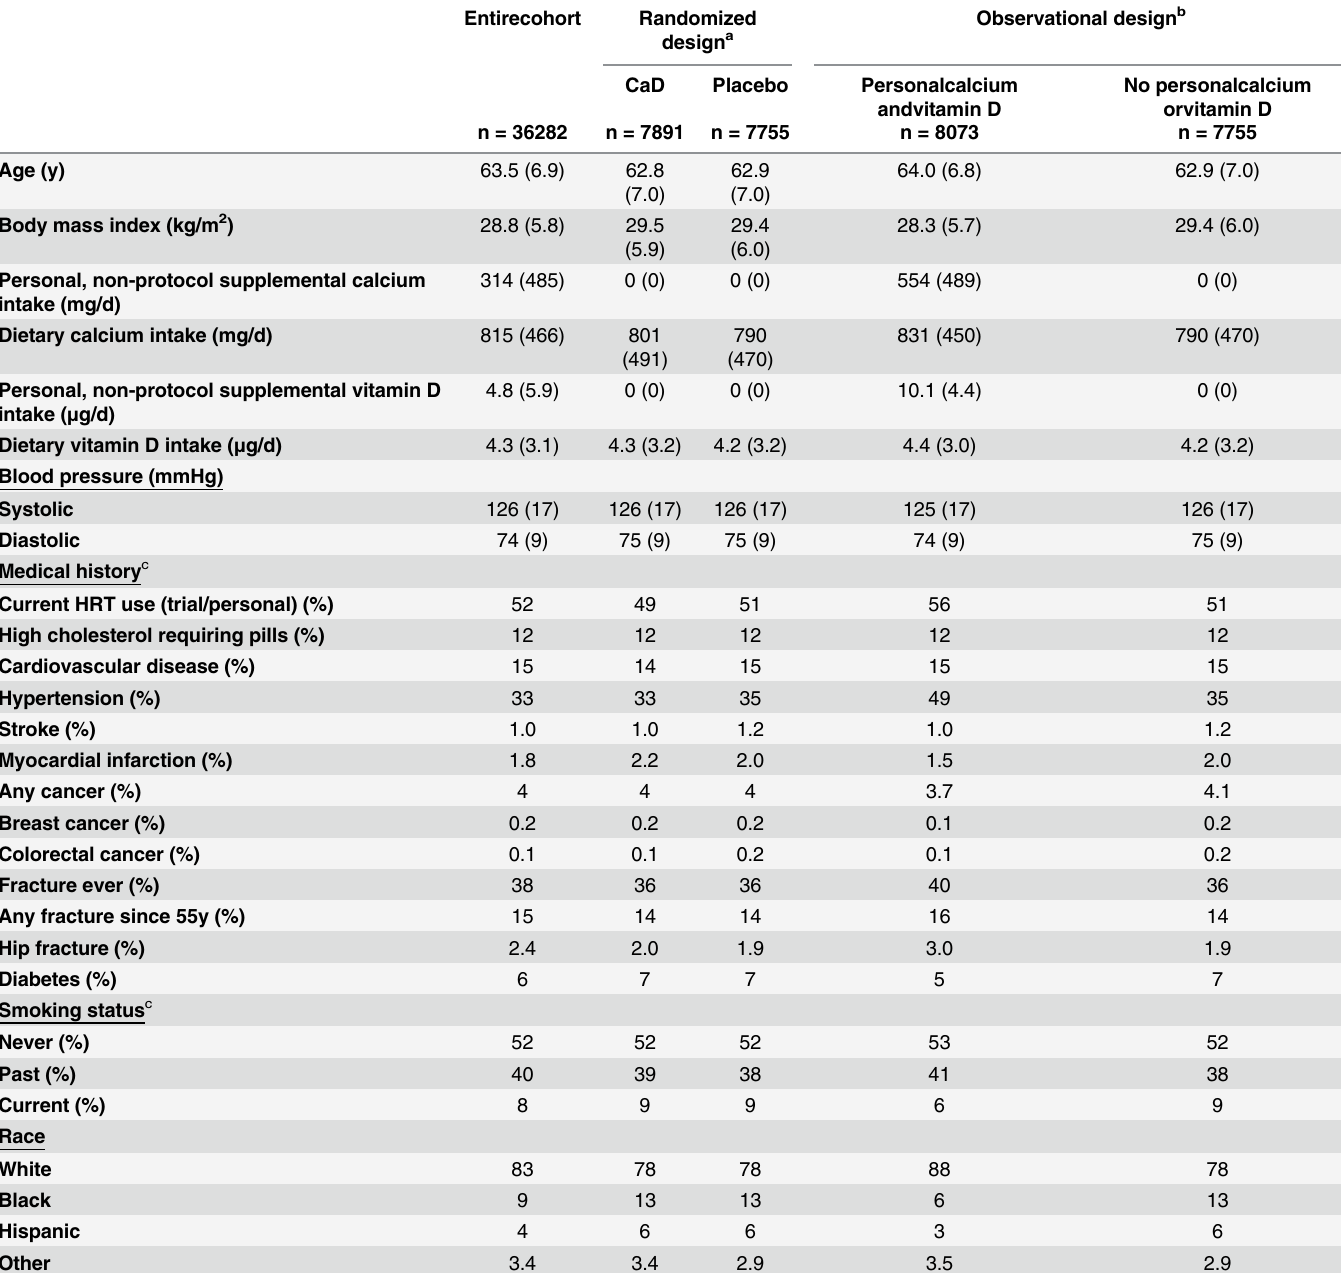
Table 1. Characteristics at randomization in the entire cohort, and in subgroups defined by treatment allocation and by use of personal calcium or vitamin